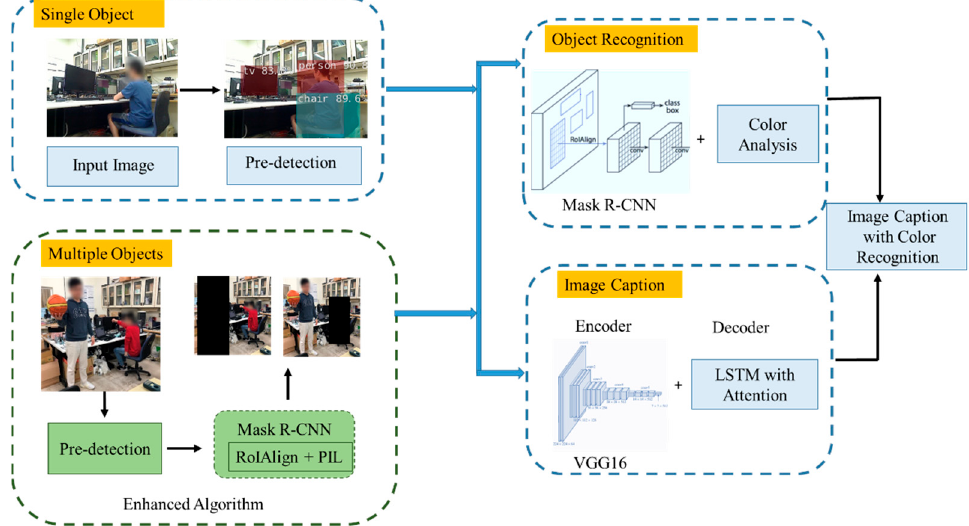
Figure 1. Overview of the proposed image captioning model.